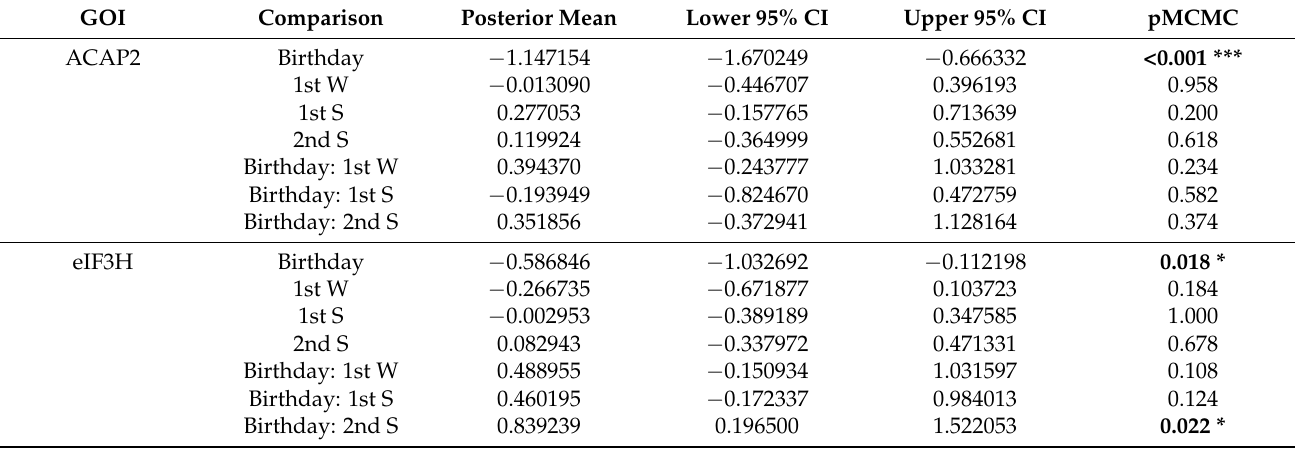
Table 5. Two-way factorial mixed effects model for collection site-dependent and seasonal effects on transcript abundance of Porites astreoides following reciprocal transplantation between an inshore patch reef (Birthday Reef) and offshore bank reef (Acer 24). The results for the three genes of interest (GOI) adenylate cyclase associated protein 2 (ACAP2), eukaryotic made to transcript abundances of samples transplanted to Acer24 Reef and sampled during the 2nd W seasons. Note: